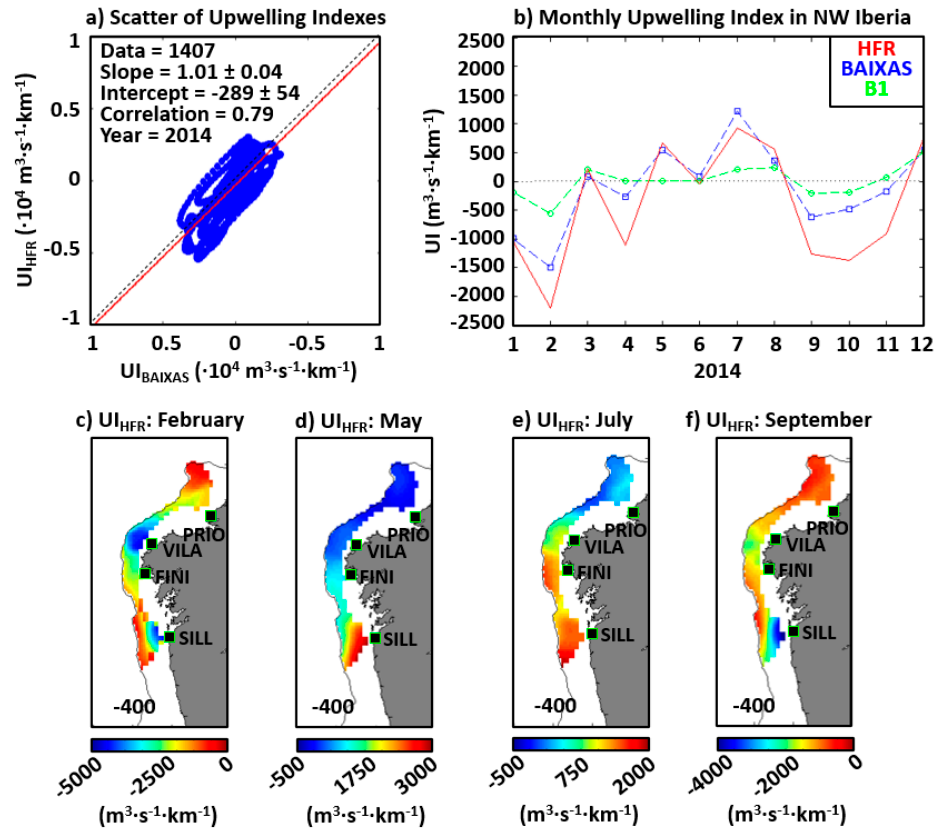
Figure 11. ( a ) Best linear fit of scatter plot between two different coastal upwelling indexes, for the entire year 2014; ( b ) Annual (2014) evolution of monthly-averaged coastal upwelling indexes: upwelling index based on HFR-derived hourly surface current observations (UI HFR ) = red line, upwelling index based on hourly data of sea level pressure (UI BAIXAS ) = blue line and upwelling index based on wind (UI B1 ) = green line. ( c – f ) Spatial distribution of monthly averaged UI HFR over the Galician continental shelf under predominant DOW ( c , f ) and UPW ( d , e ) conditions. Bathymetric contour shows depth at 400 m.